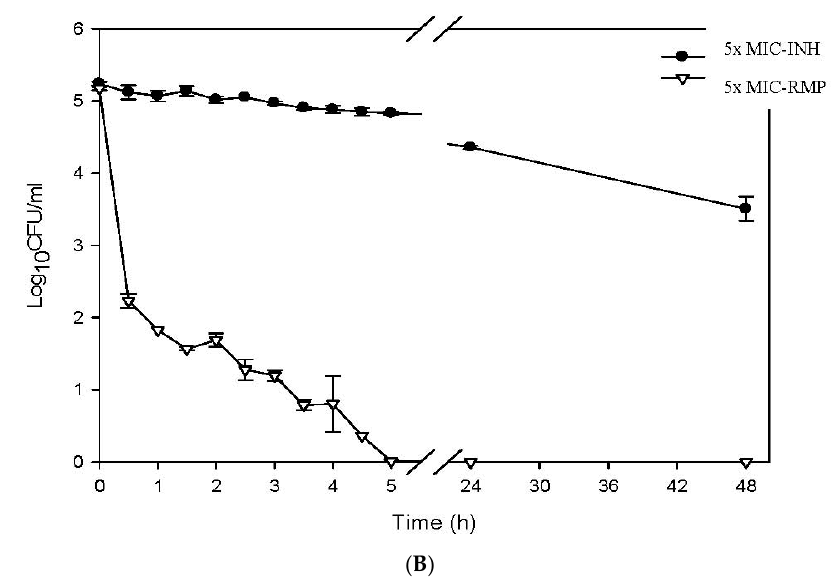
Figure 2. The time-kill curves of M. tuberculosis H37R v exposed to ( A ) rac -ACA at the concentrations of 13.5 µg/mL (5× MIC) and 2.7 µg/mL (1× MIC) and ( B ) 0.5 µg/mL of INH (5× MIC) and 2.0 µg/mL of RMP (5× MIC). Mean values and error bars of standard deviation values.